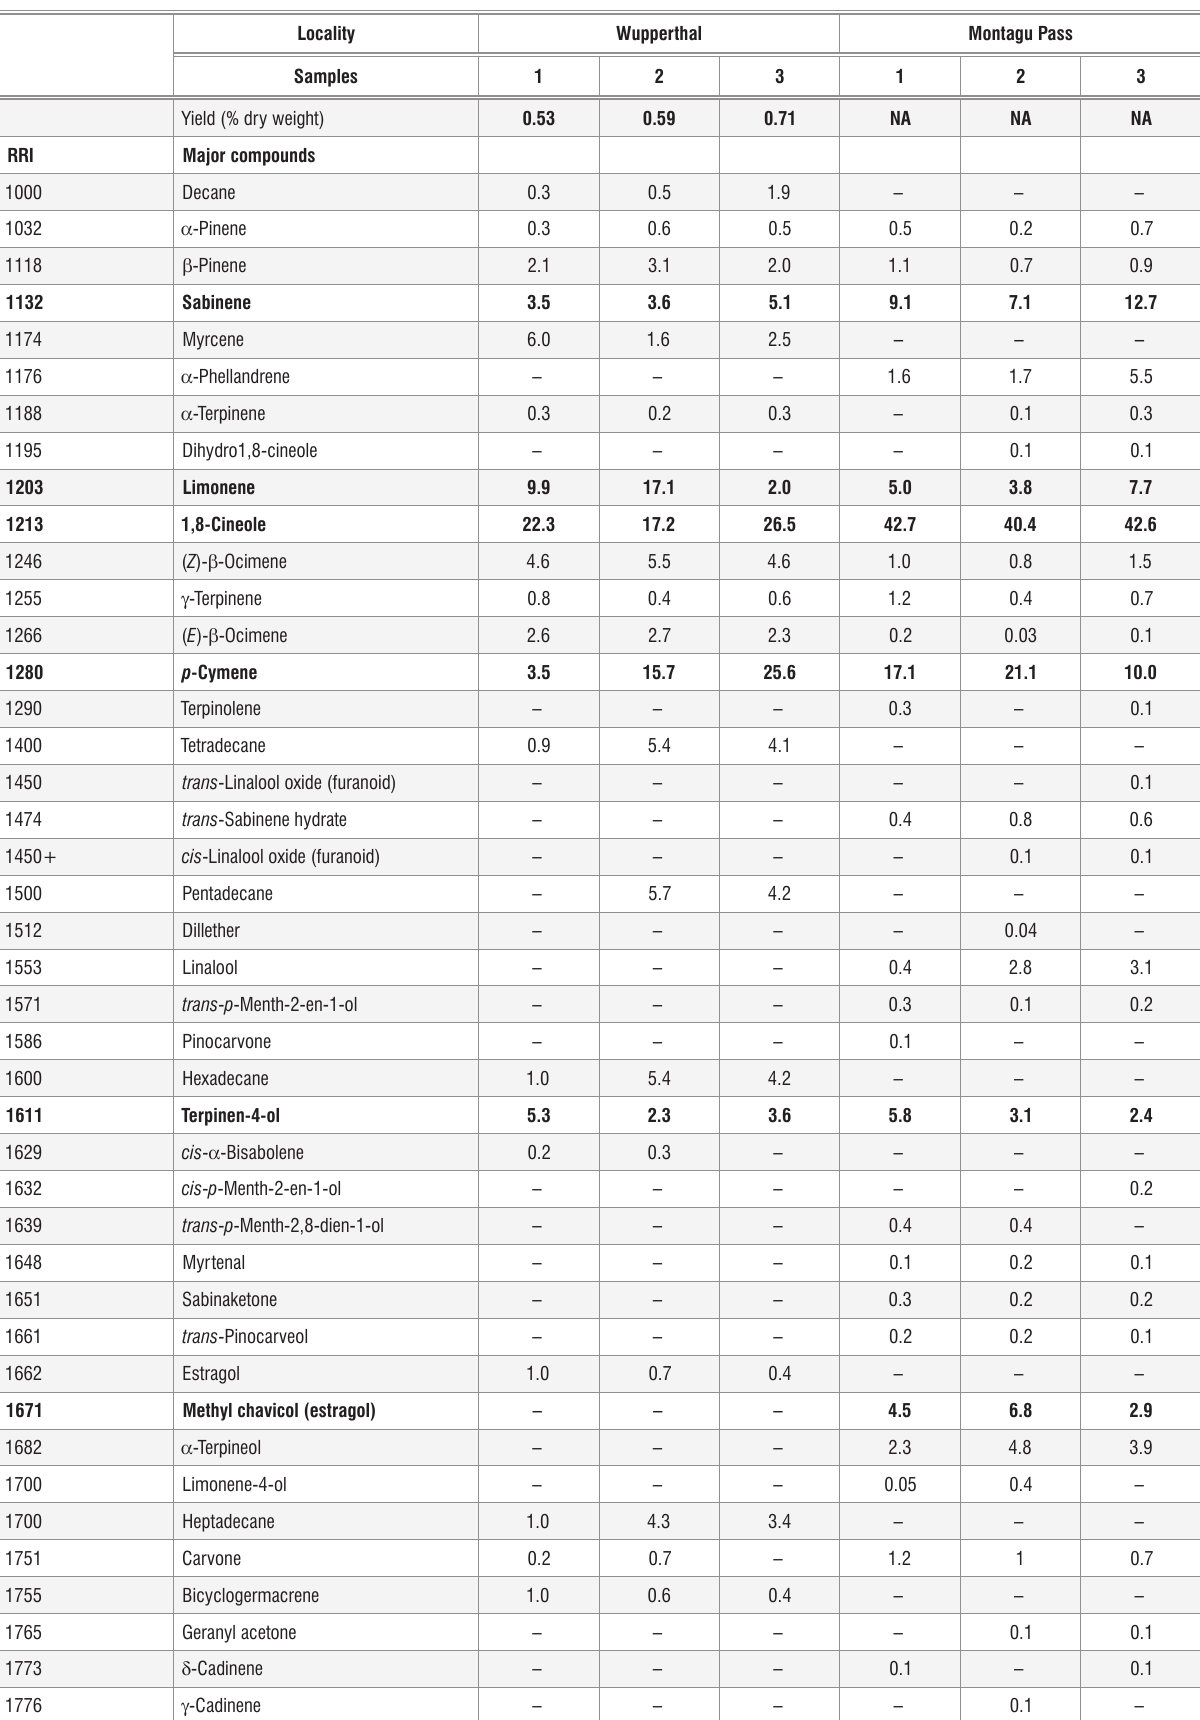
Table 3: Compounds of six samples of Pteronia camphorata as identified by GC–MS (percentage area) Locality Wupperthal Montagu